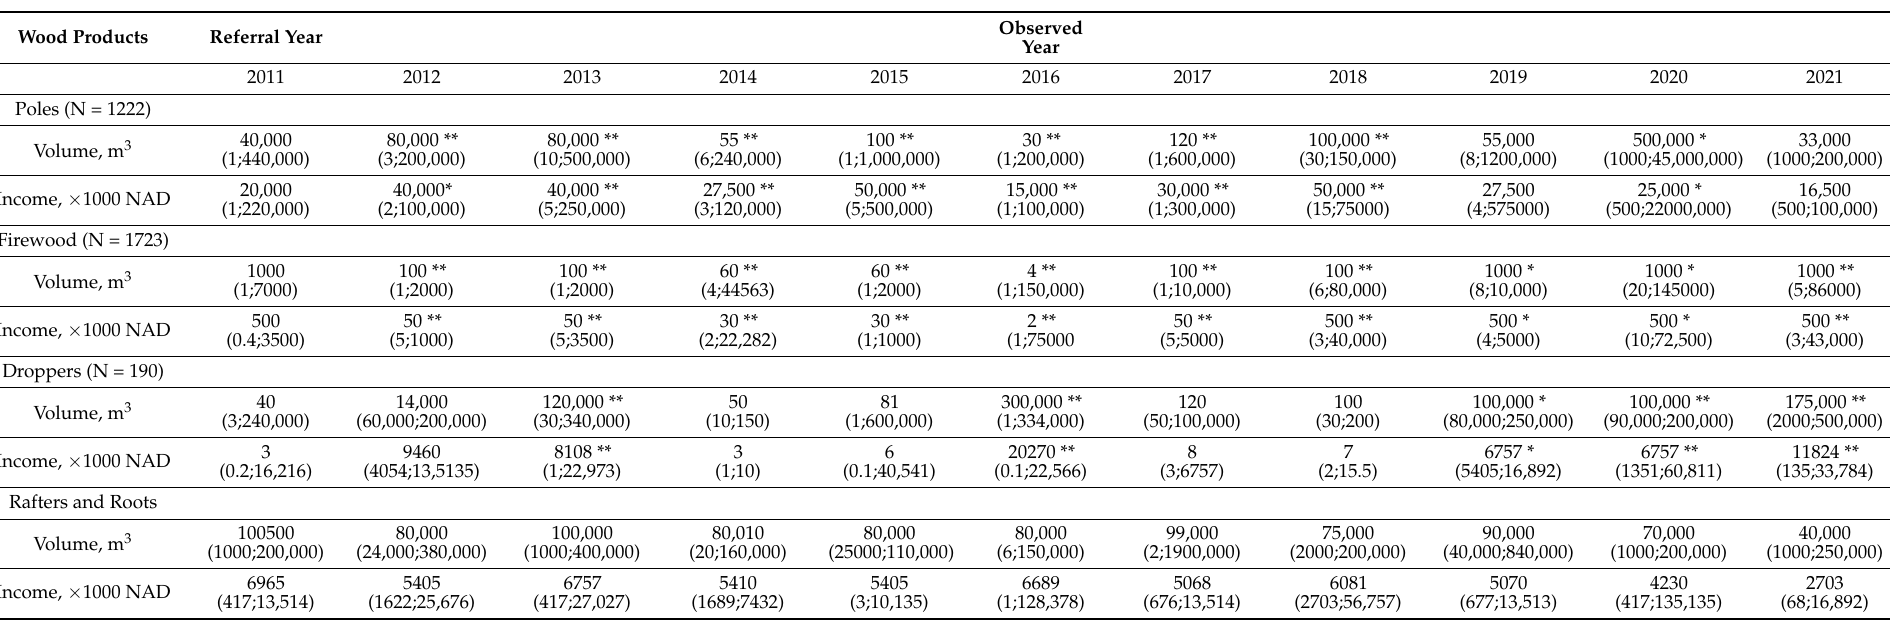
Table A1. Changes in wood product volume collection compared to the referral year (2021) 1